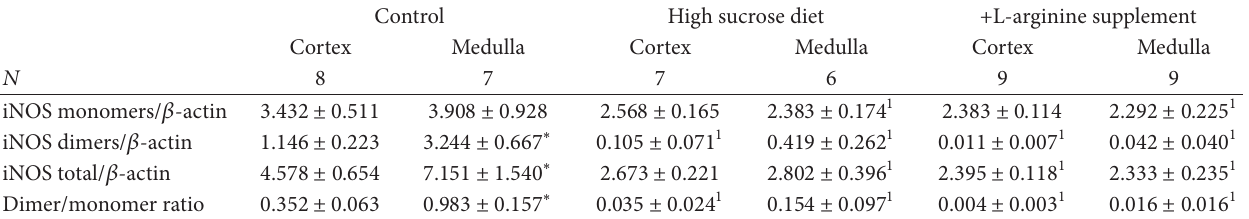
Table 2: Effect of a high sucrose diet and L-arginine supplementation on iNOS/ 𝛽 -actin ratio in the kidney cortex and medulla.